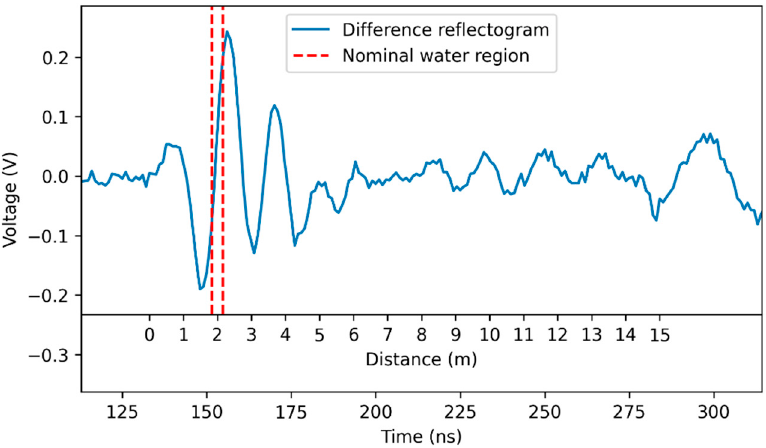
Figure 12. Difference between the reflectogram measured in the presence of water (Figure 11) and the reference reflectogram (Figure 9). The indicative distance scale depicted in the Figure starts from the position of the pulse reflected at the coaxial/SE interface and ends at the position of the pulse reflected at the SE